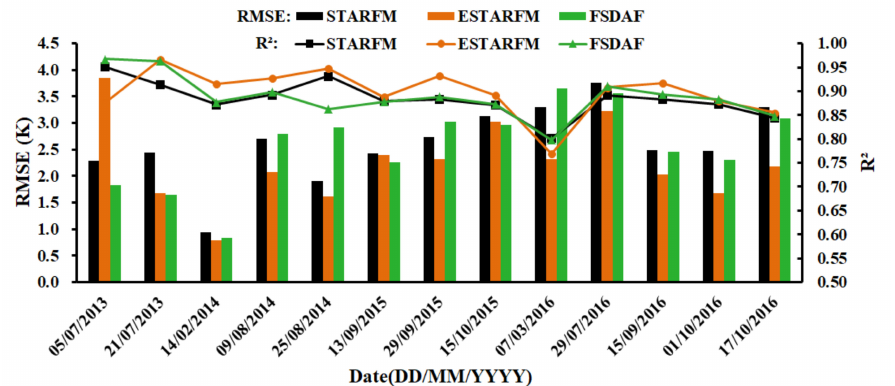
Figure 6. The R 2 and RMSE (K) of fused LST images and actual LST